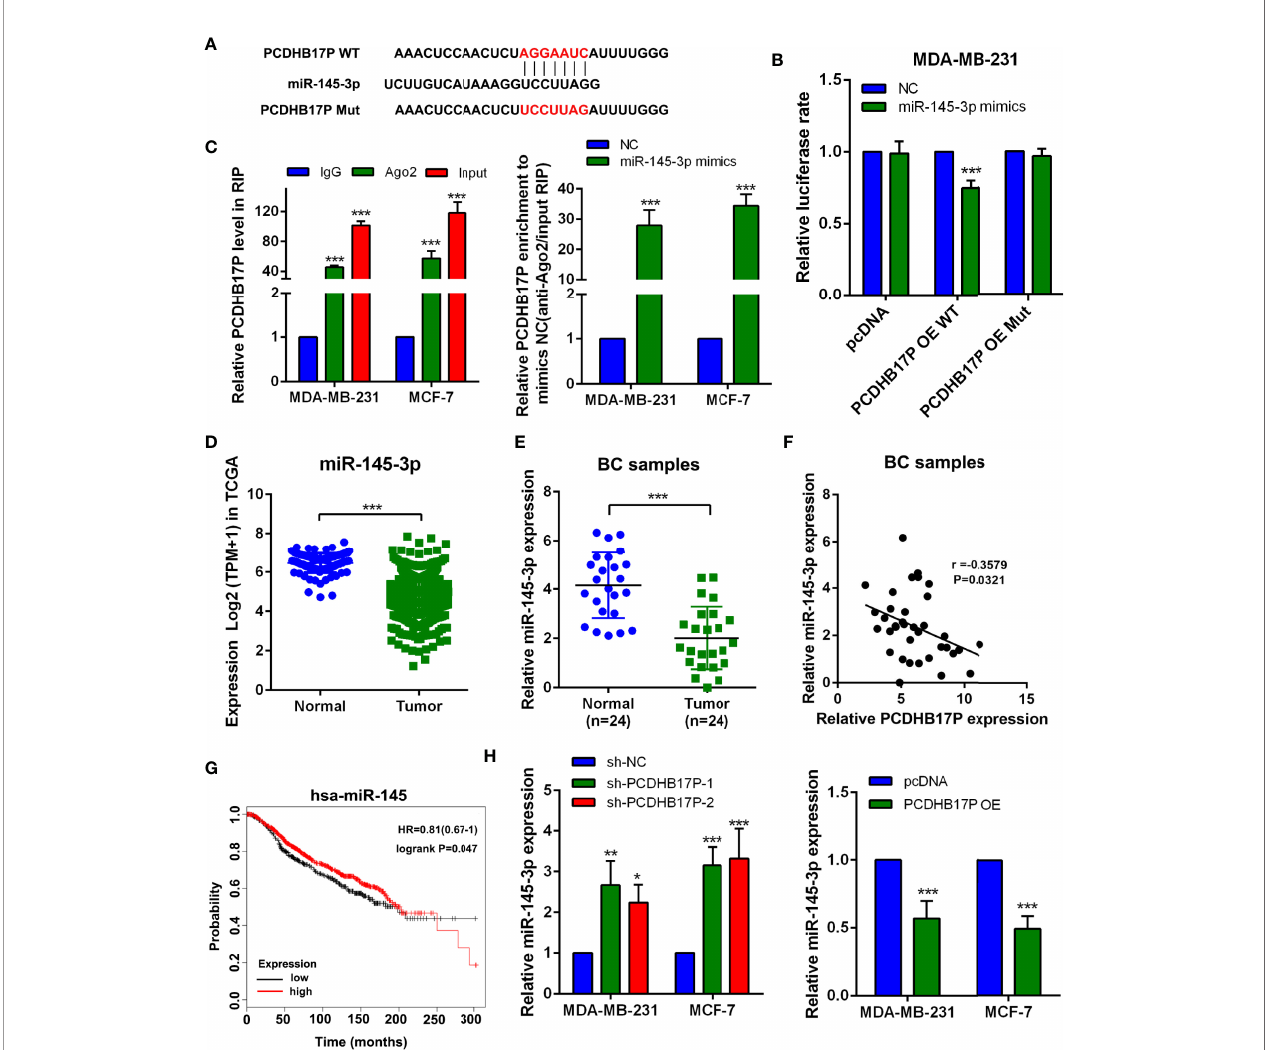
FIGURE 4 | PCDHB17P competes with miR-145-3p in breast cancer cells (A) The predicted miR-145-3p binding sites in the PCDHB17P transcript. (B) The luciferase activities in MDA-MB-231 cells co-transfected with wild-type (WT) or mutant PCDHB17P plasmid together with miR-145-3p mimic or miR-NC. (C) RIP experiments revealed the enrichment of PCDHB17P and miR-145-3p in the Ago2 immunoprecipitation compared with the control IgG precipitation. (D) The expression of miR-145-3p were analyzed in breast cancer and normal epithelial tissues by TCGA. (E) The expression of miR-145-3p were detected in breast cancer and normal tissues by RT-qPCR. (F) Correlation between PCDHB17P and miR-145-3p expression in breast cancer clinical samples. (G) Kaplan-Meier analysis of the correlation between miR-145-3p expression and overall survival in TCGA database. (H) The expression of miR-145-3p was detected in MDA-MB-231 and MCF-7 cells transfected with PCDHB17P overexpression plasmid or sh-PCDHB17P by RT-qPCR. * P < 0.05, ** P < 0.01, *** P <